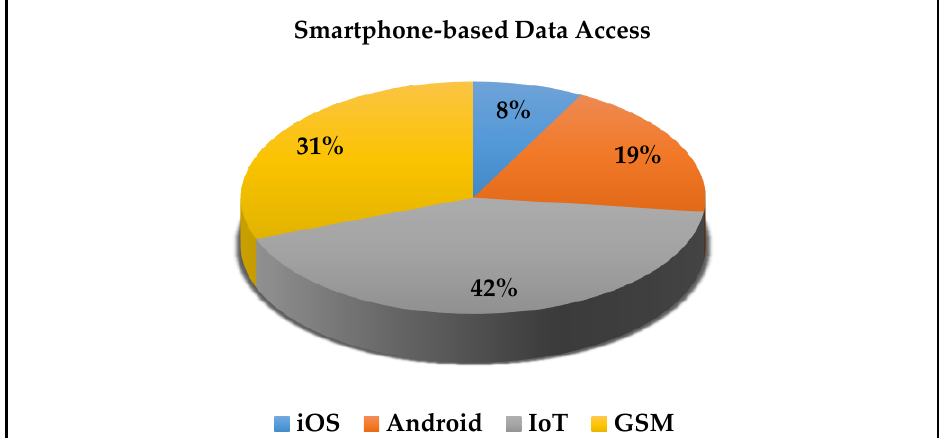
Figure 8. Data access platforms for smartphone-based systems.